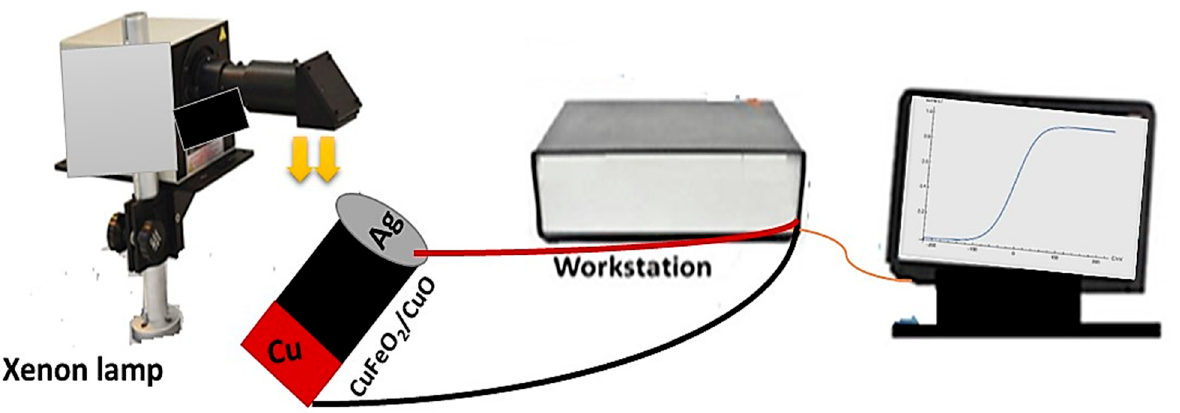
Figure 1. A schematic diagram of the method used to measure the optoelectronic